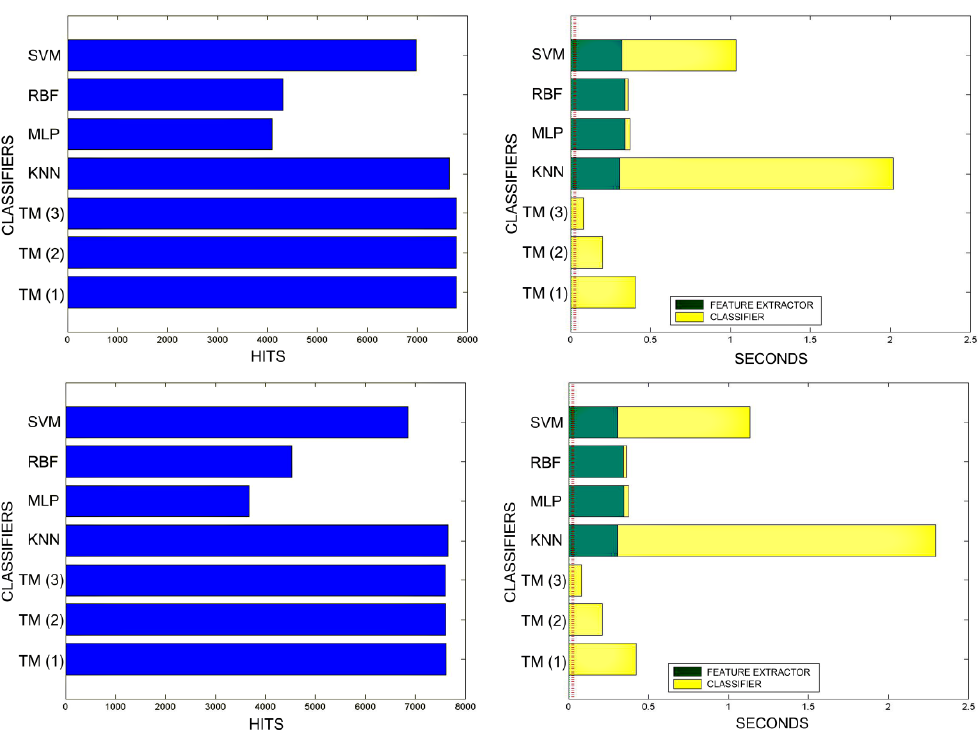
right, feature extractor in green, and classification in yellow. In descending order the training sets